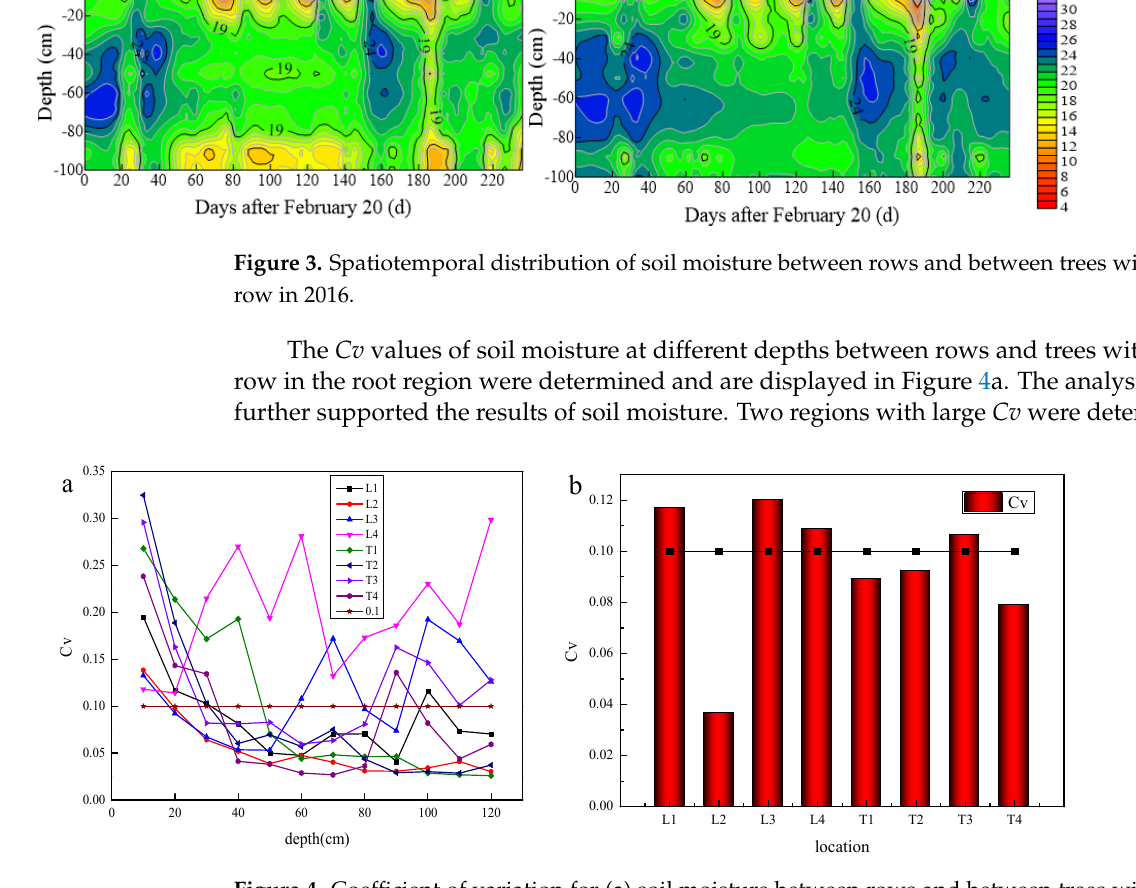
Figure 3. Spatiotemporal distribution of soil moisture between rows and between trees within the row in 2016.